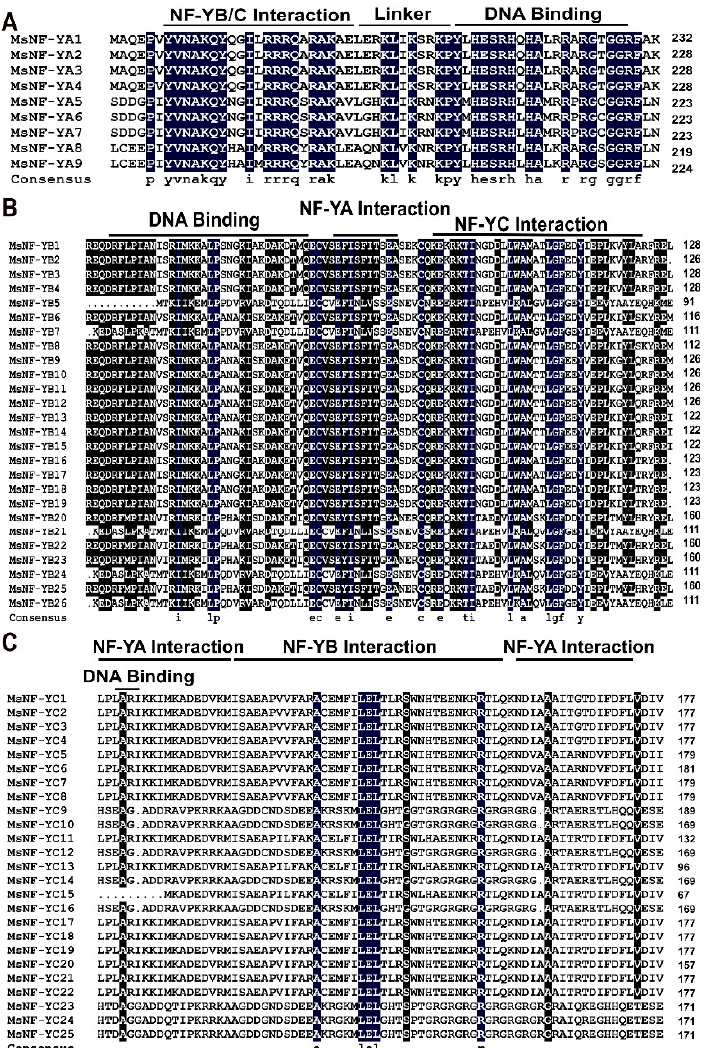
Figure 2. Conserved domain alignments of MsNF-Y members. ( A ) MsNF-YA proteins; ( B ) MsNF-YB proteins; ( C ) MsNF-YC proteins.